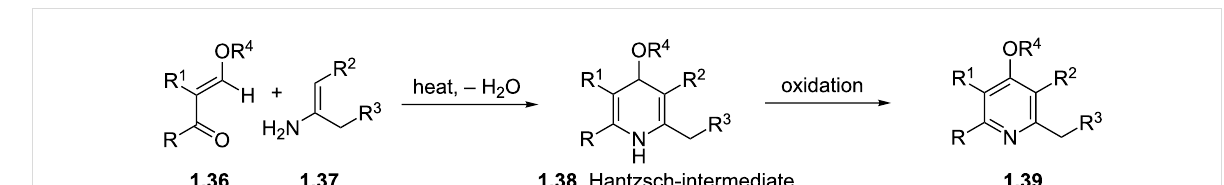
Scheme 6: Mode of action of proton-pump inhibitors and structures of the API’s.